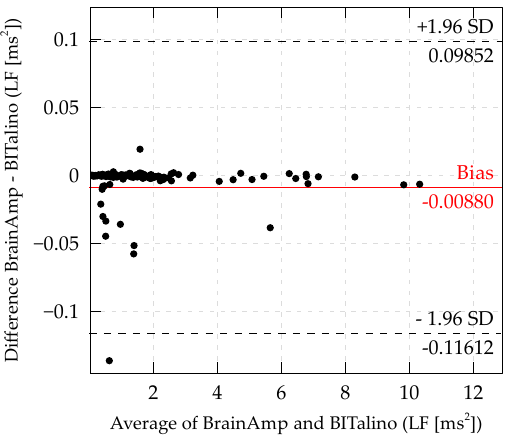
Figure 6. Bland–Altman plot of LF. (Some data points outside the LoA are cutoff to offer a more detailed view of the distribution inside the